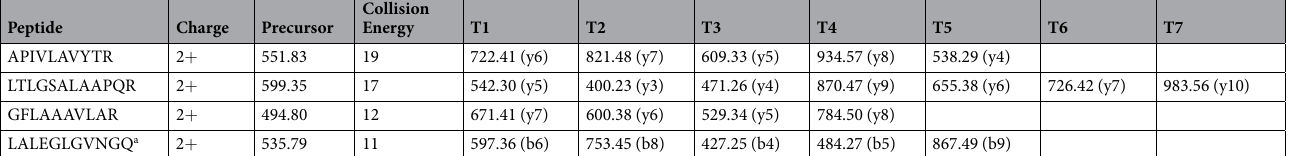
Table 2. Four high-confidence core peptide markers for KPC. a Only b-ions were included in data processing due to deamidation in N or Q even though all b-ion and y-ion data were available. This peptide was not included in the validation set due to deamindation.